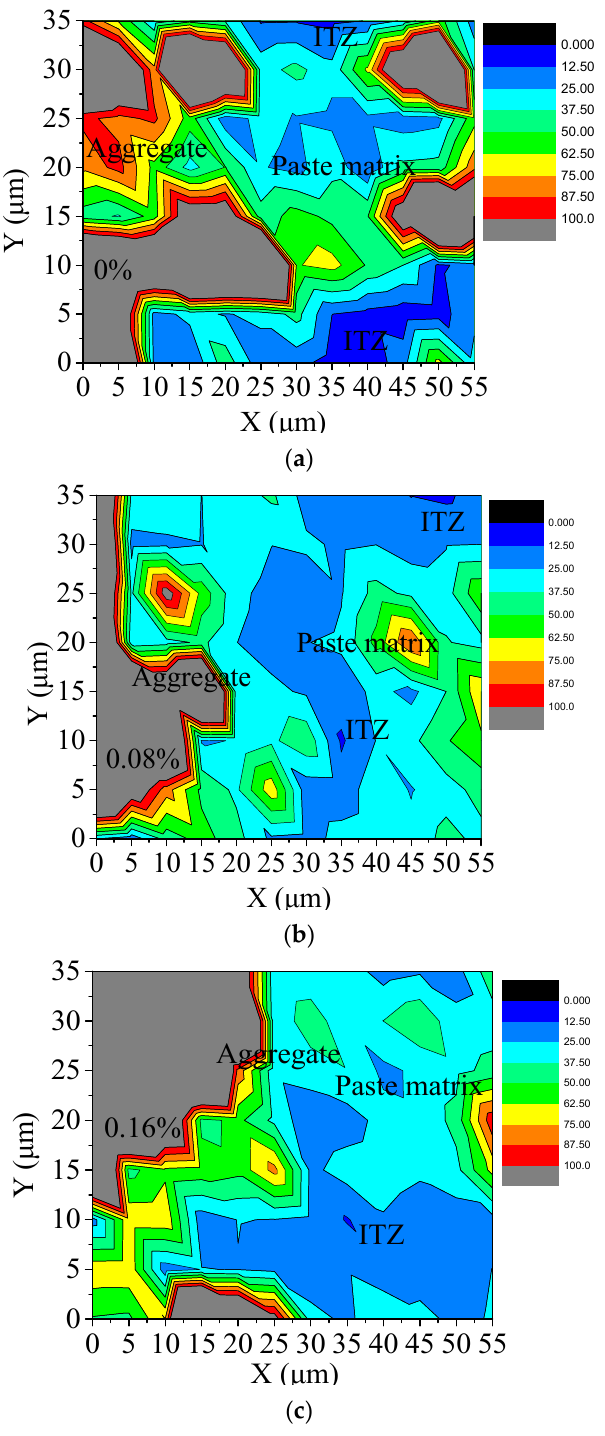
Figure 5. Contour map of the indentation modulus with different content of NSN. ( a ) N5 without NSN. ( b ) N6 with 0.08% content of NSN. ( c ) N7 with 0.16% content of